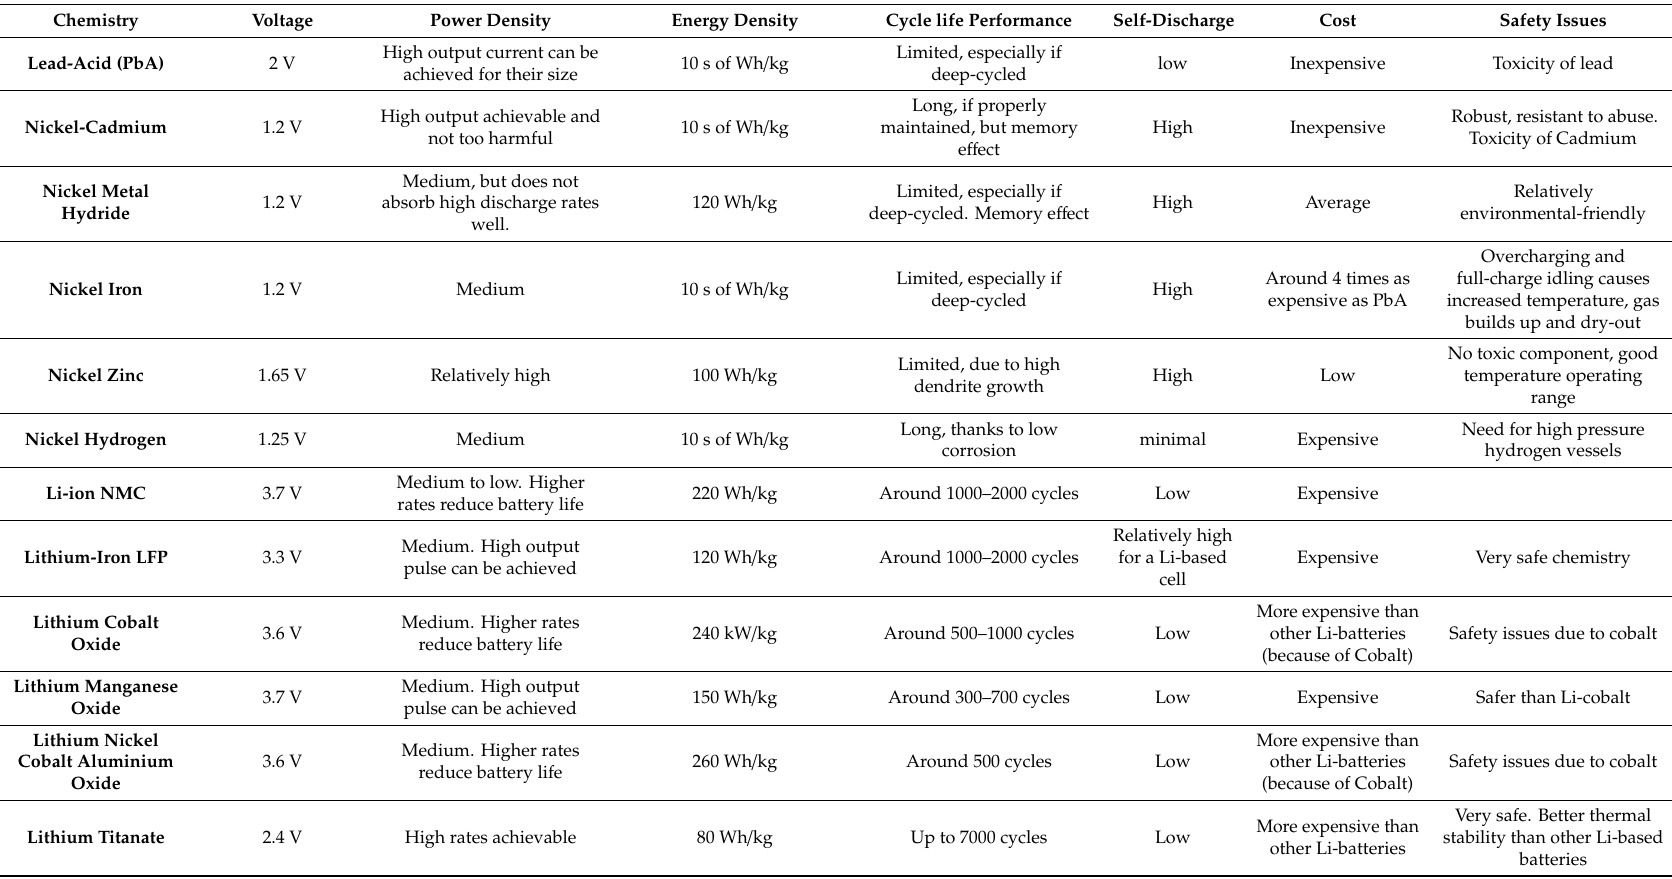
Table 1. Features of the main battery